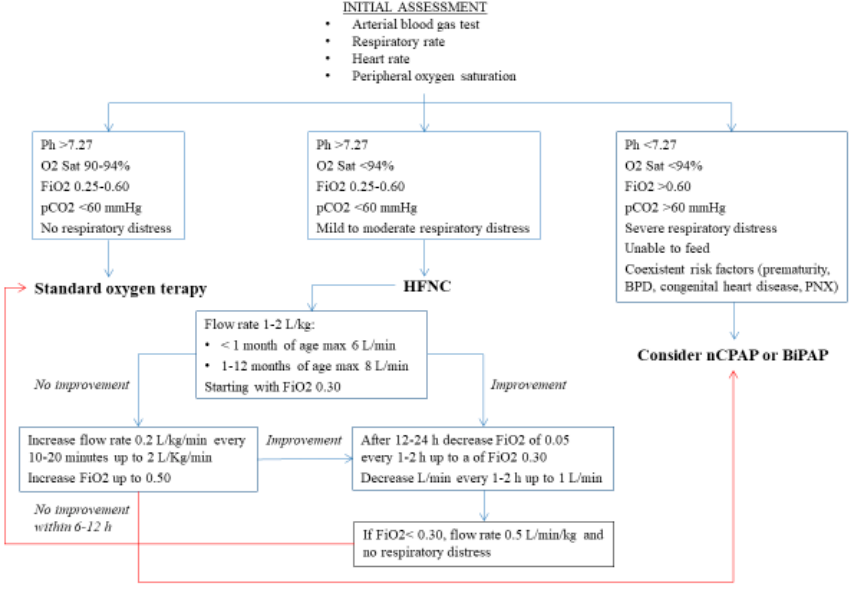
Figure 1. Practical flowchart about when to start standard oxygen therapy (SOT), high-flow nasal cannula (HFNC), or other methods of non-invasive ventilation in infants with bronchiolitis (BR). RR, respiratory rate; HR, heart rate.